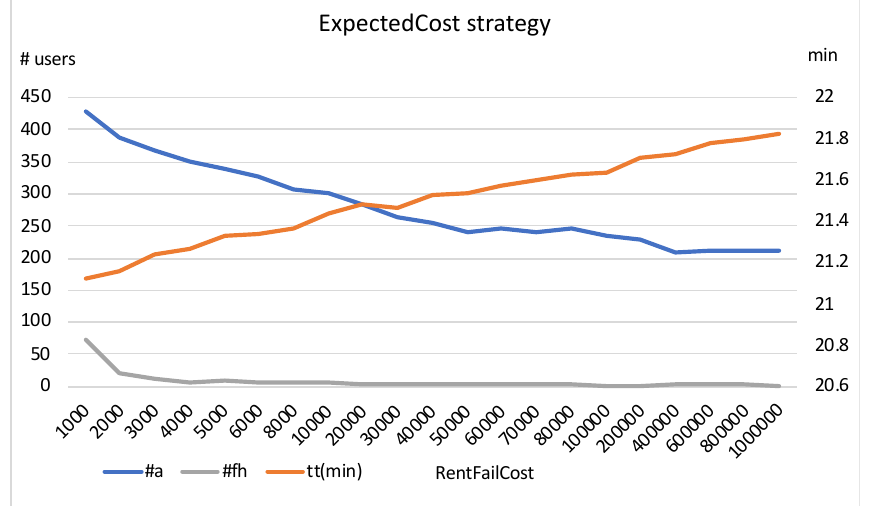
Figure 3. ExpectedCost strategy with variable RentFailCost and fixed ReturnFailCost = 2000.